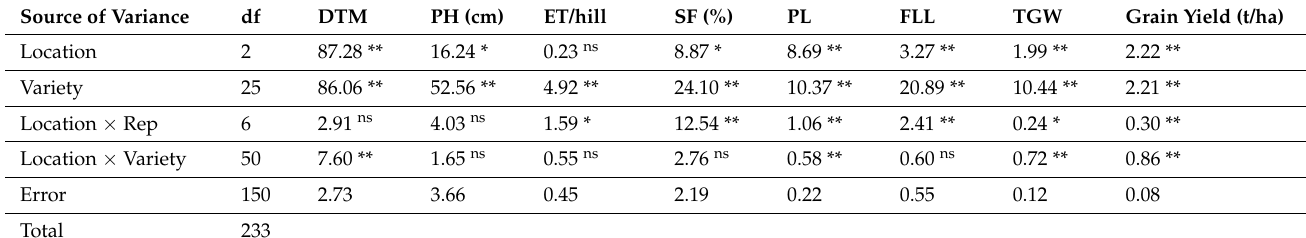
Table 2. Analysis of variance for grain yield and its related traits in some hybrid